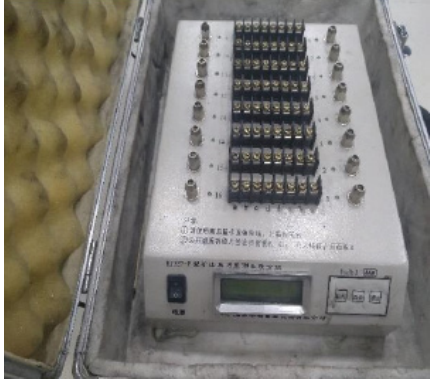
Figure 9. KJ327-F strain data collector.